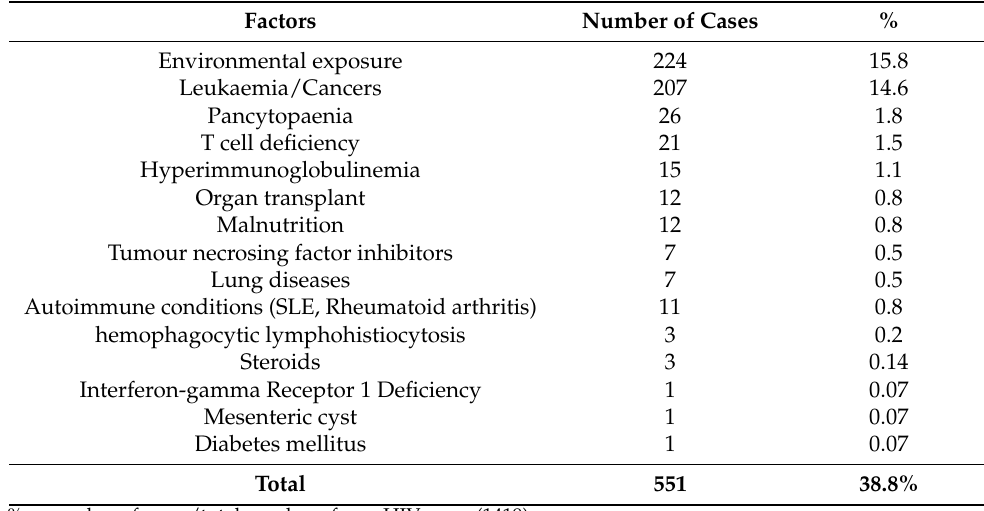
Table 2. Percentages of non-HIV factors predisposing to pediatric histoplasmosis.